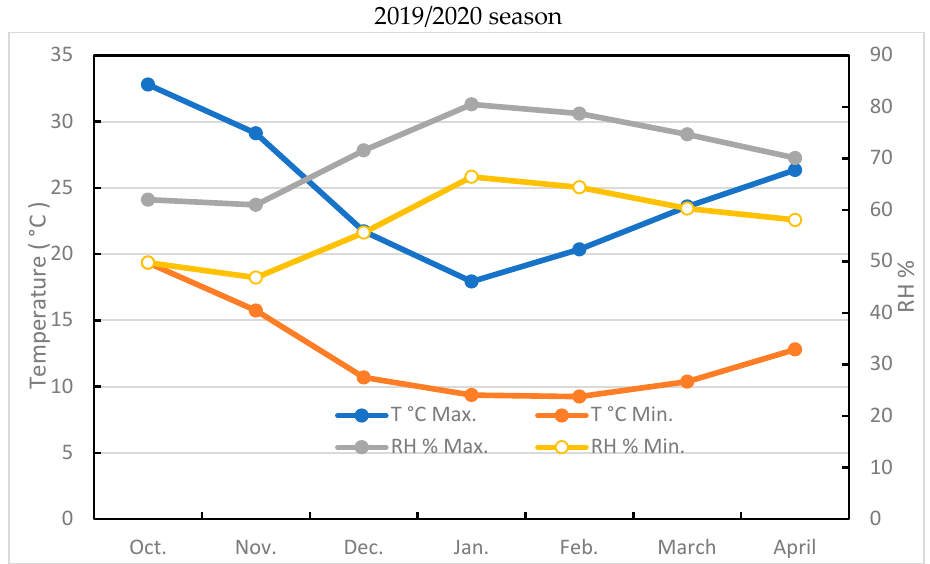
Figure 1. Average maximum and minimum temperature and relative humidity per month during the study in both seasons.